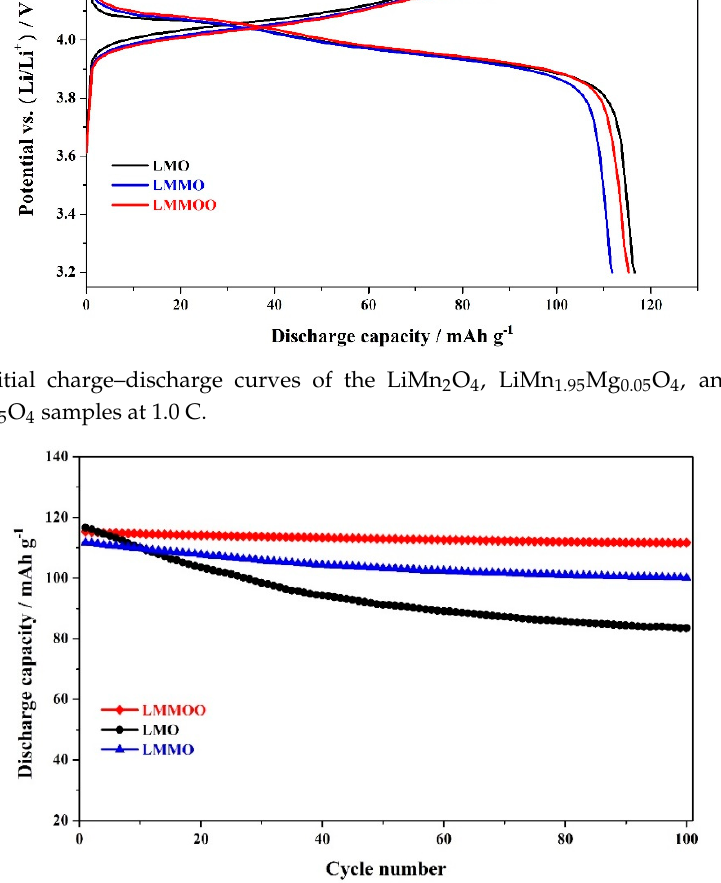
Figure 4. Cycling stability of the LiMn 2 O 4 , LiMn 1.95 Mg 0.05 O 4 , and octahedral LiMn 1.95 Mg 0.05 O 4 samples at 1.0 C.